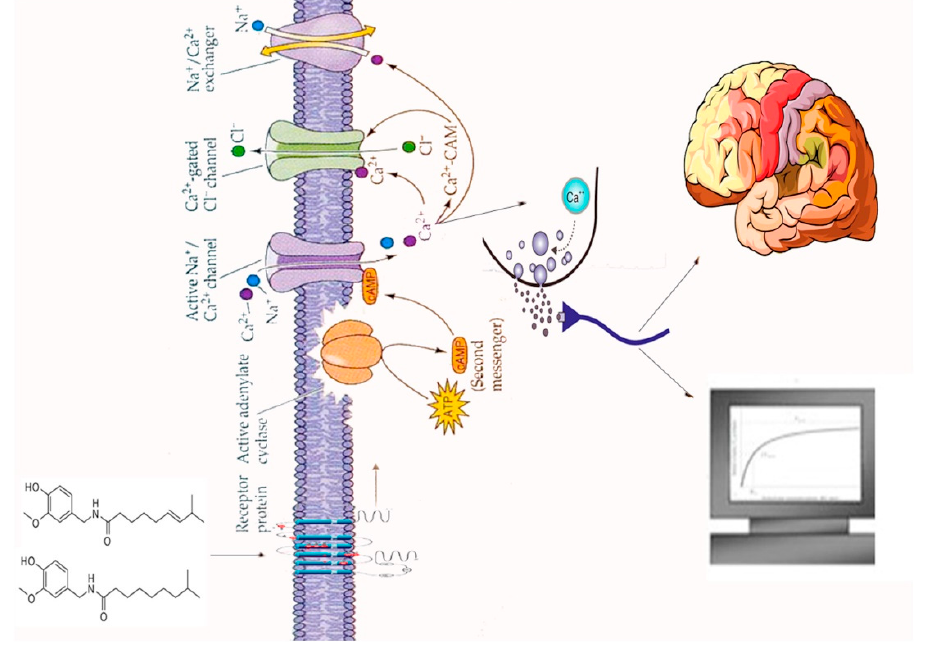
Figure 11. Rat tongue mucosa coupled to electrochemical system to detect pungent compounds. Reprinted from ref. [105] with permission of Elsevier.